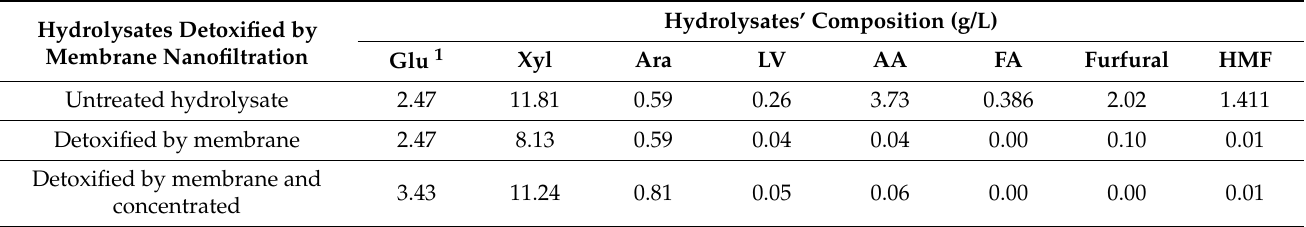
Table 2. Cardoon hydrolysates’ composition on monosaccharides and inhibitors before and after nanofiltration membrane detoxification and